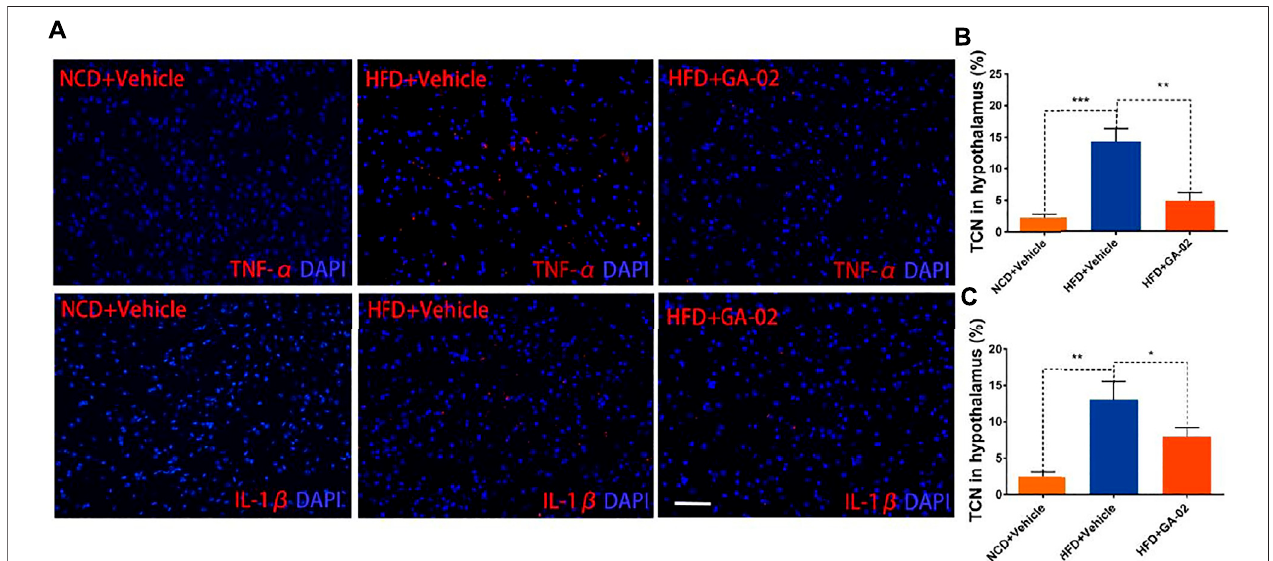
FIGURE9| Representativeimages ofimmunostainingforTNF- α and IL-1 β inthe hypothalamus. Theimmunostaining offorDAPI and TNF- α [ (A) ,upper panel] and IL-1 β [ (B) , lower panel] was conducted from hypothalamus of NCD fed mice or DIO mice that were treated with vehicle and GA-02 (20 mg/kg; i.p.) for 7 days. The percentage of positive TNF- α (B) and IL-1 β (C) from total cell number (TCN) was quanti fi ed. Scale bar, 100 µm. (* p < 0.05, ** p < 0.01, *** p < 0.001).